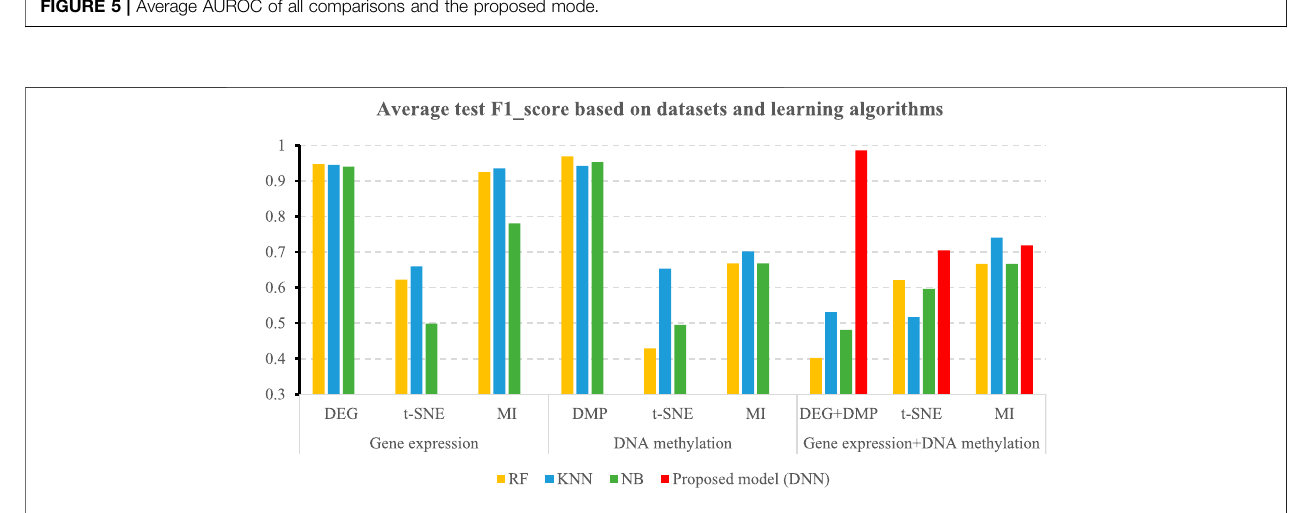
FIGURE 6 | Average F1-score of all comparisons and the proposed mode.